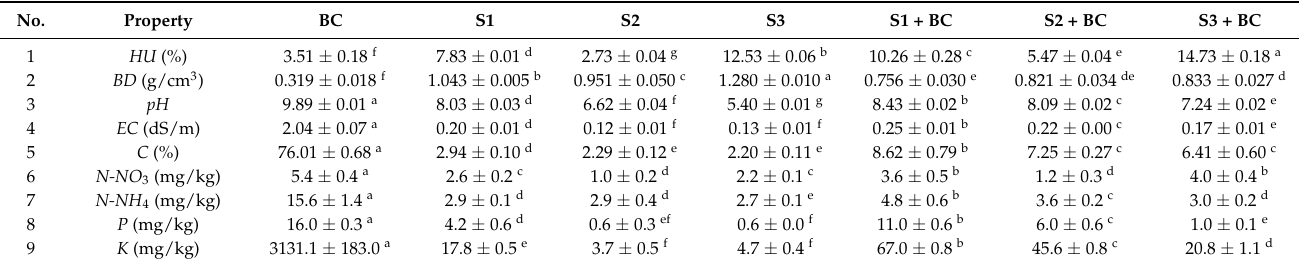
Table 3. Mean values ± SD of physicochemical properties of BC amendment, non-amended soils (S), and BC-amended soils (S +